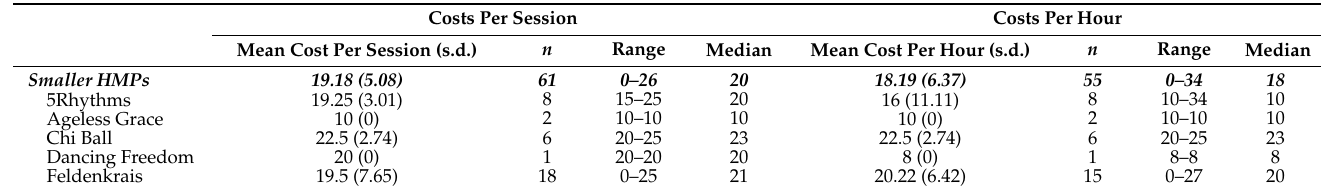
Table 3. Costs for weekly classes, per session and per hour (in Australian dollars). Costs Per Session Costs Per Hour Mean Cost Per Session